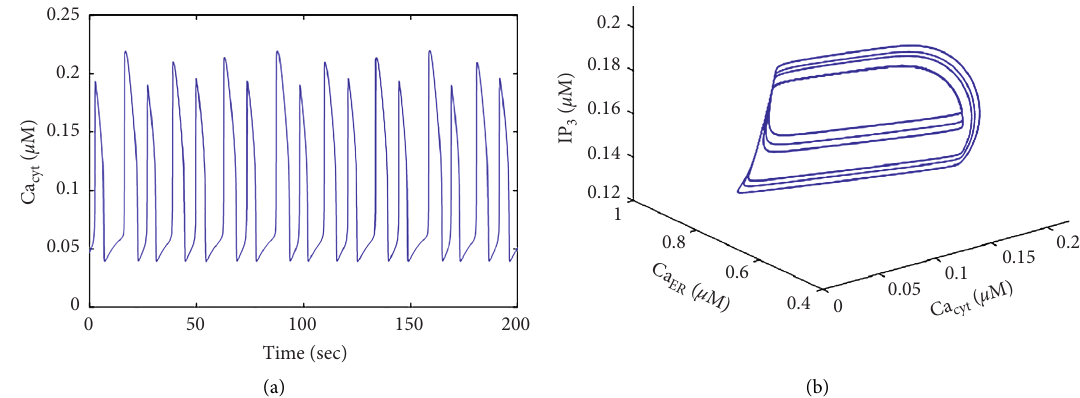
Figure 4: Time evolution of regular burst spontaneous Ca2+ oscillations in astrocytes. (a) v diagram in ( x , y , z )-plane for v